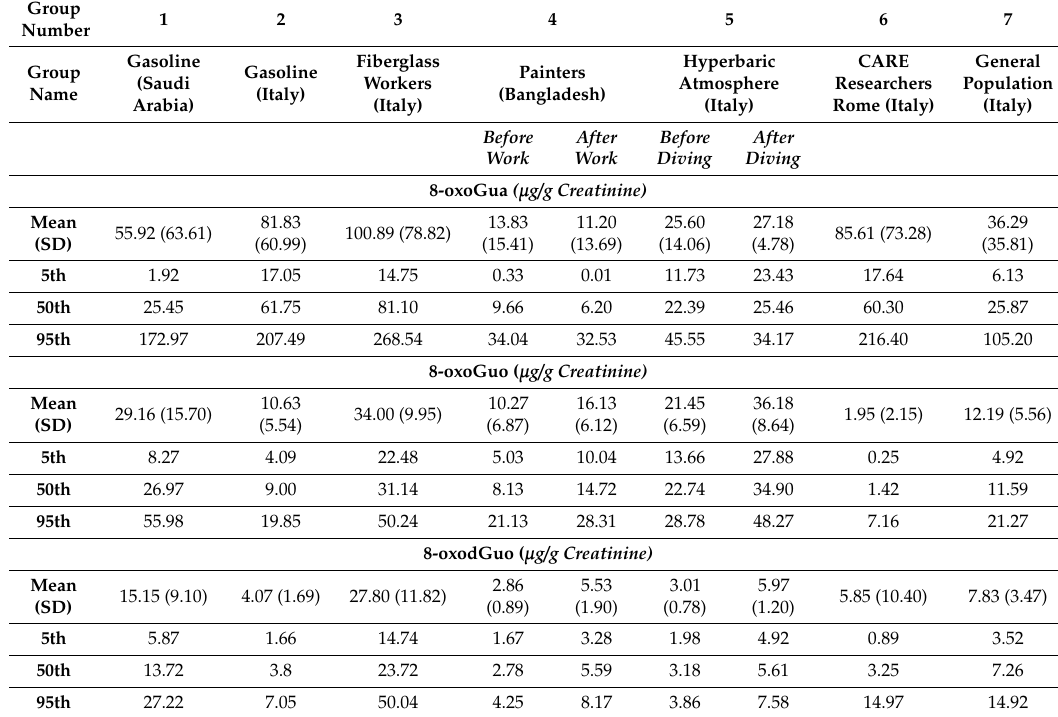
Table 3. Concentrations ( µ g / g creatinine) of the oxidation biomarkers in all groups.